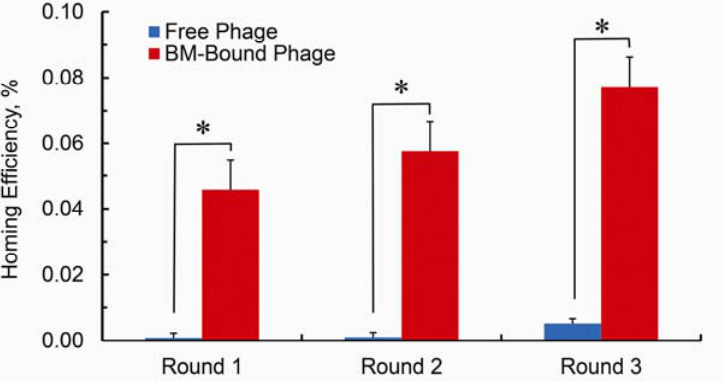
Figure 2. Homing efficiency of the phage pool from each selection cycle, calculated as the ratio of output phage titer to input phage titer multiplied by 100. Using BM cells to deliver phage to tumors improves the efficiency of the selection procedure in the range of 50-fold. The bars show standard error of the mean (s.e.m.) from plating quadruplicates. P values were calculated by Student’s t-test and were considered statistically significant at P <